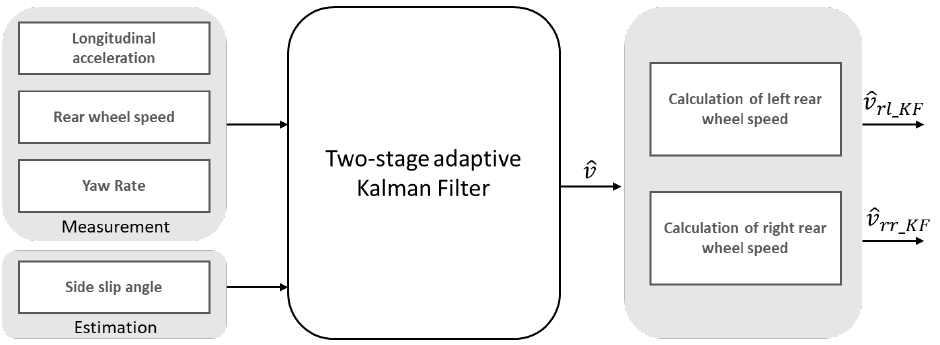
Figure 4. Structure of the estimation of rear wheel